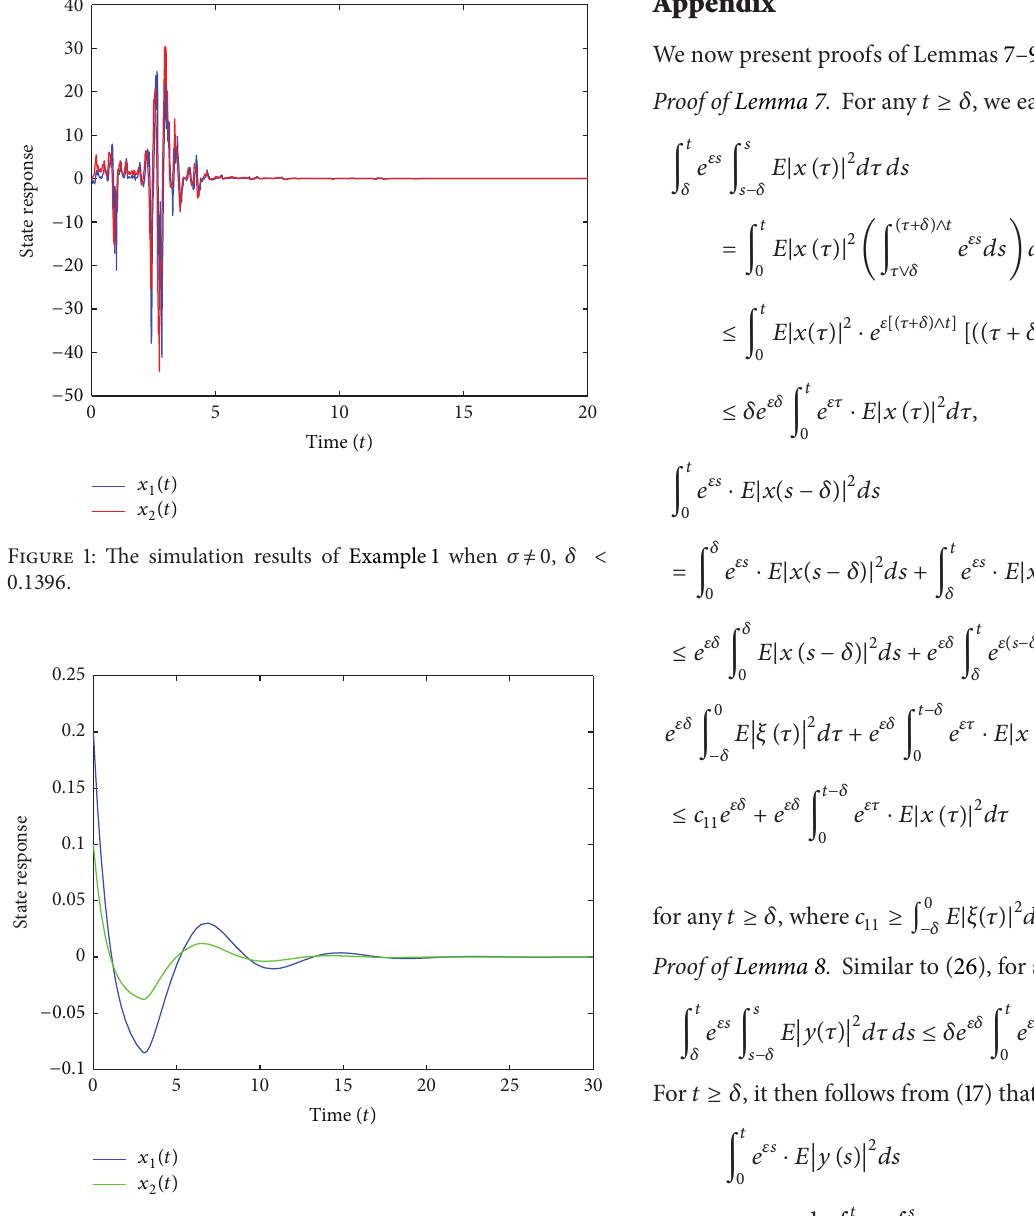
Figure 2: The simulation results of Example 1 when 𝜎 ≡ 0 , 𝛿 < 0.1677